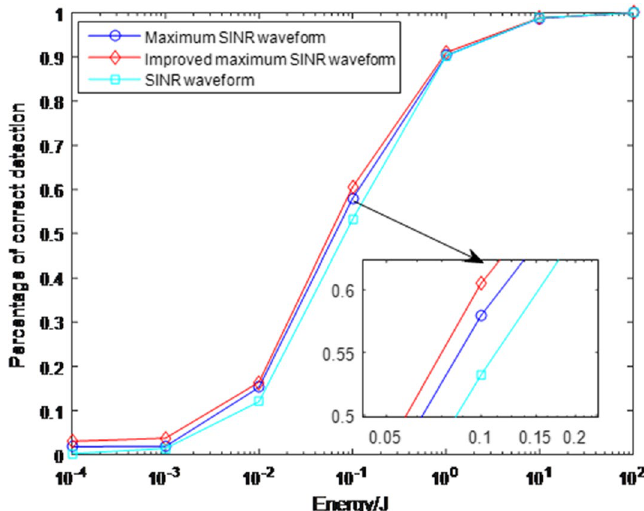
Fig. 15 Percentage of correct detection of different waveforms with minmax